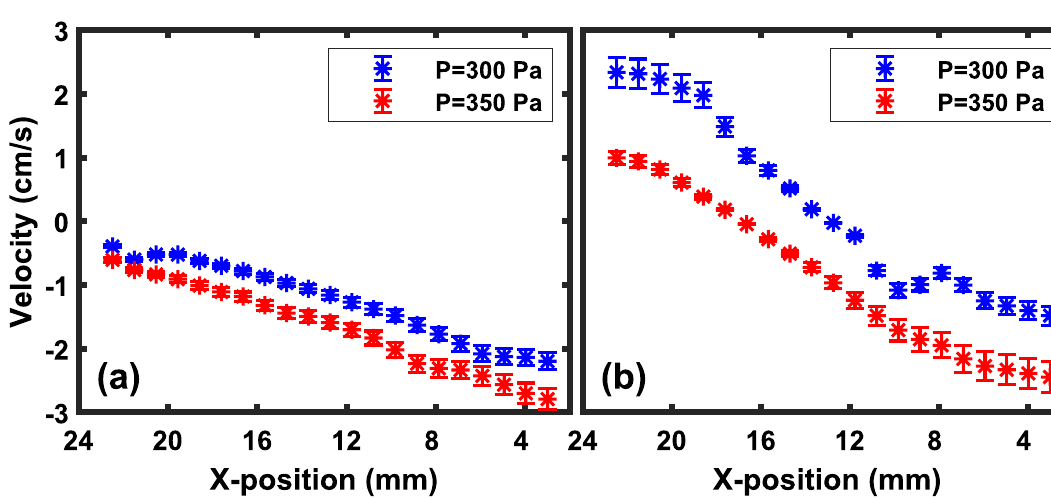
Figure 3. Variation of velocities for ( a ) single layer flow and ( b ) double layer flow, of the dust fluid along X-direction for a particular Z-position of 10 mm. Here, the dust fluid flows along the